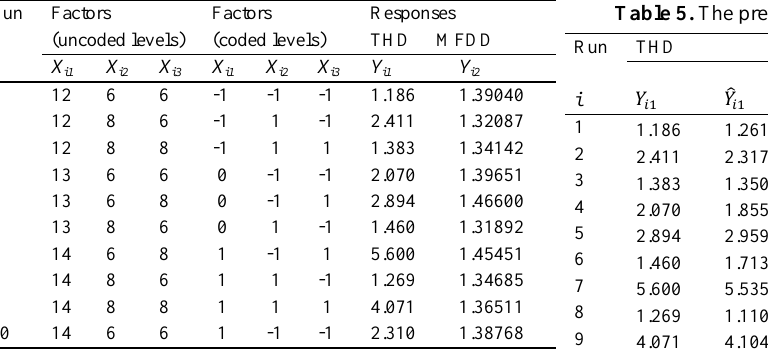
Table 4. The experimental design and Maxwell simulation results.